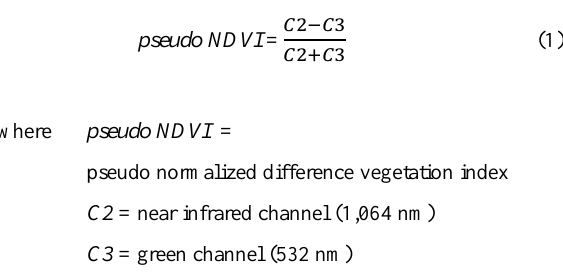
The scaled intensity values are used to create false color composites for each point. The combination red=C2, green=C3 and blue=C1 is used to simulate a CIR (color infrared) similar visual appearance, and the combination red=C1, green=C2 and blue=C3 for a true color similar appearance. The channels C2 and C3 are used to calculate a pseudo NDVI (Eq.